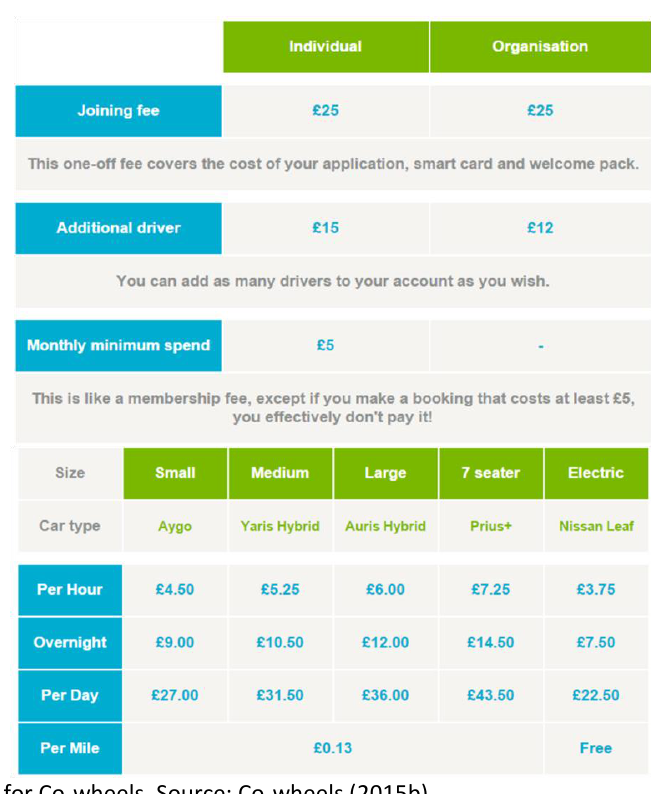
Figure 7. Cost structure for City Car Club. Source: City Car Club (2015b).